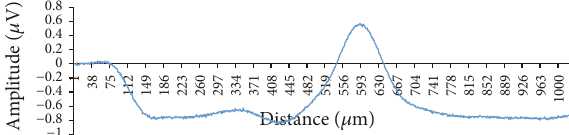
Figure 6: Electrical noise suppression with SNR digital filtering of 38.59